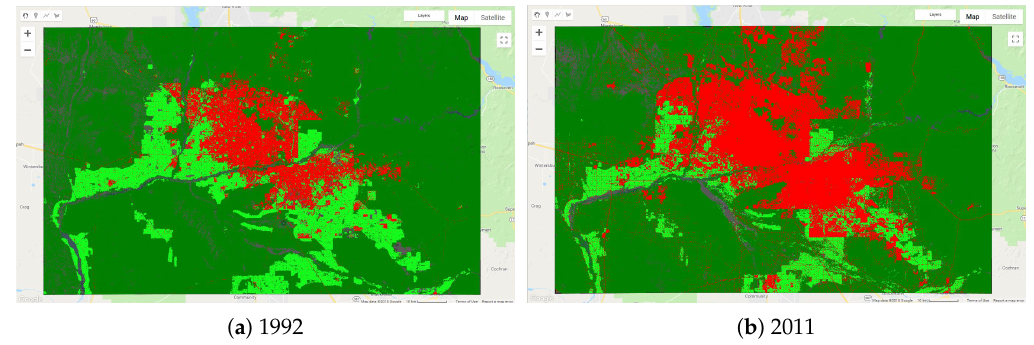
Figure 18. Phoenix MA: LC situation in 1992 ( a ) and in 2011 ( b ). In red, the Urbanized class, in light green, the Cultivated class, in dark green, the Forest and Shrubland classes.